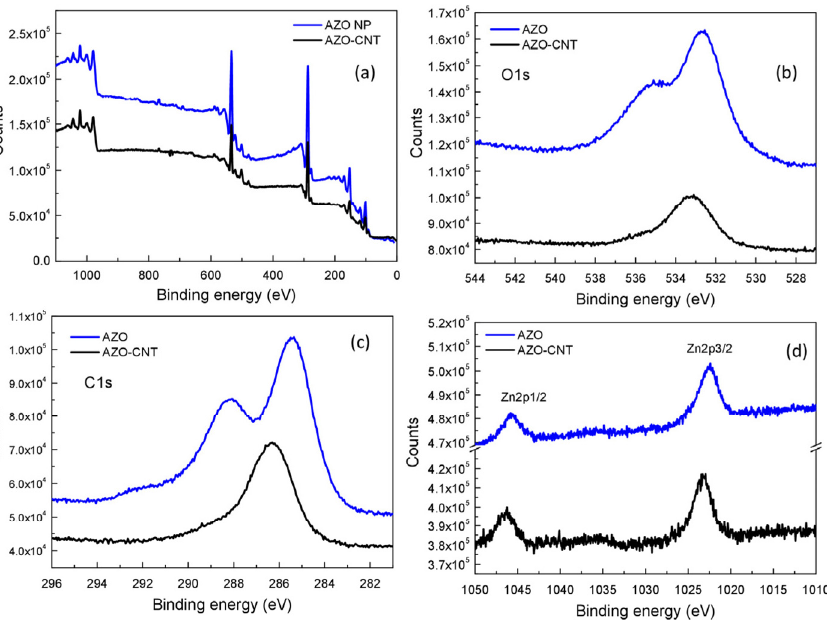
Figure 4. XPS overview spectra ( a ) and ( b ) C1s, ( c ) O1s, and ( d ) Zn2p spectra of AZO–NPs and AZO-decorated